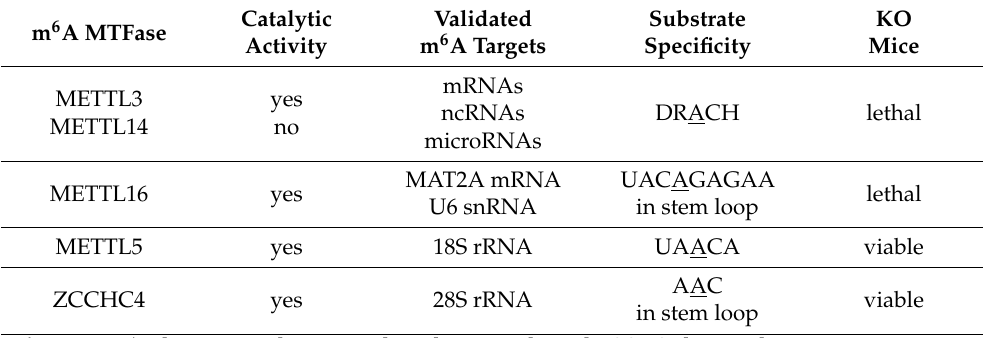
Table 1. Specificity of m 6 A writers. Modified residue is underlined. m 6 A MTFase